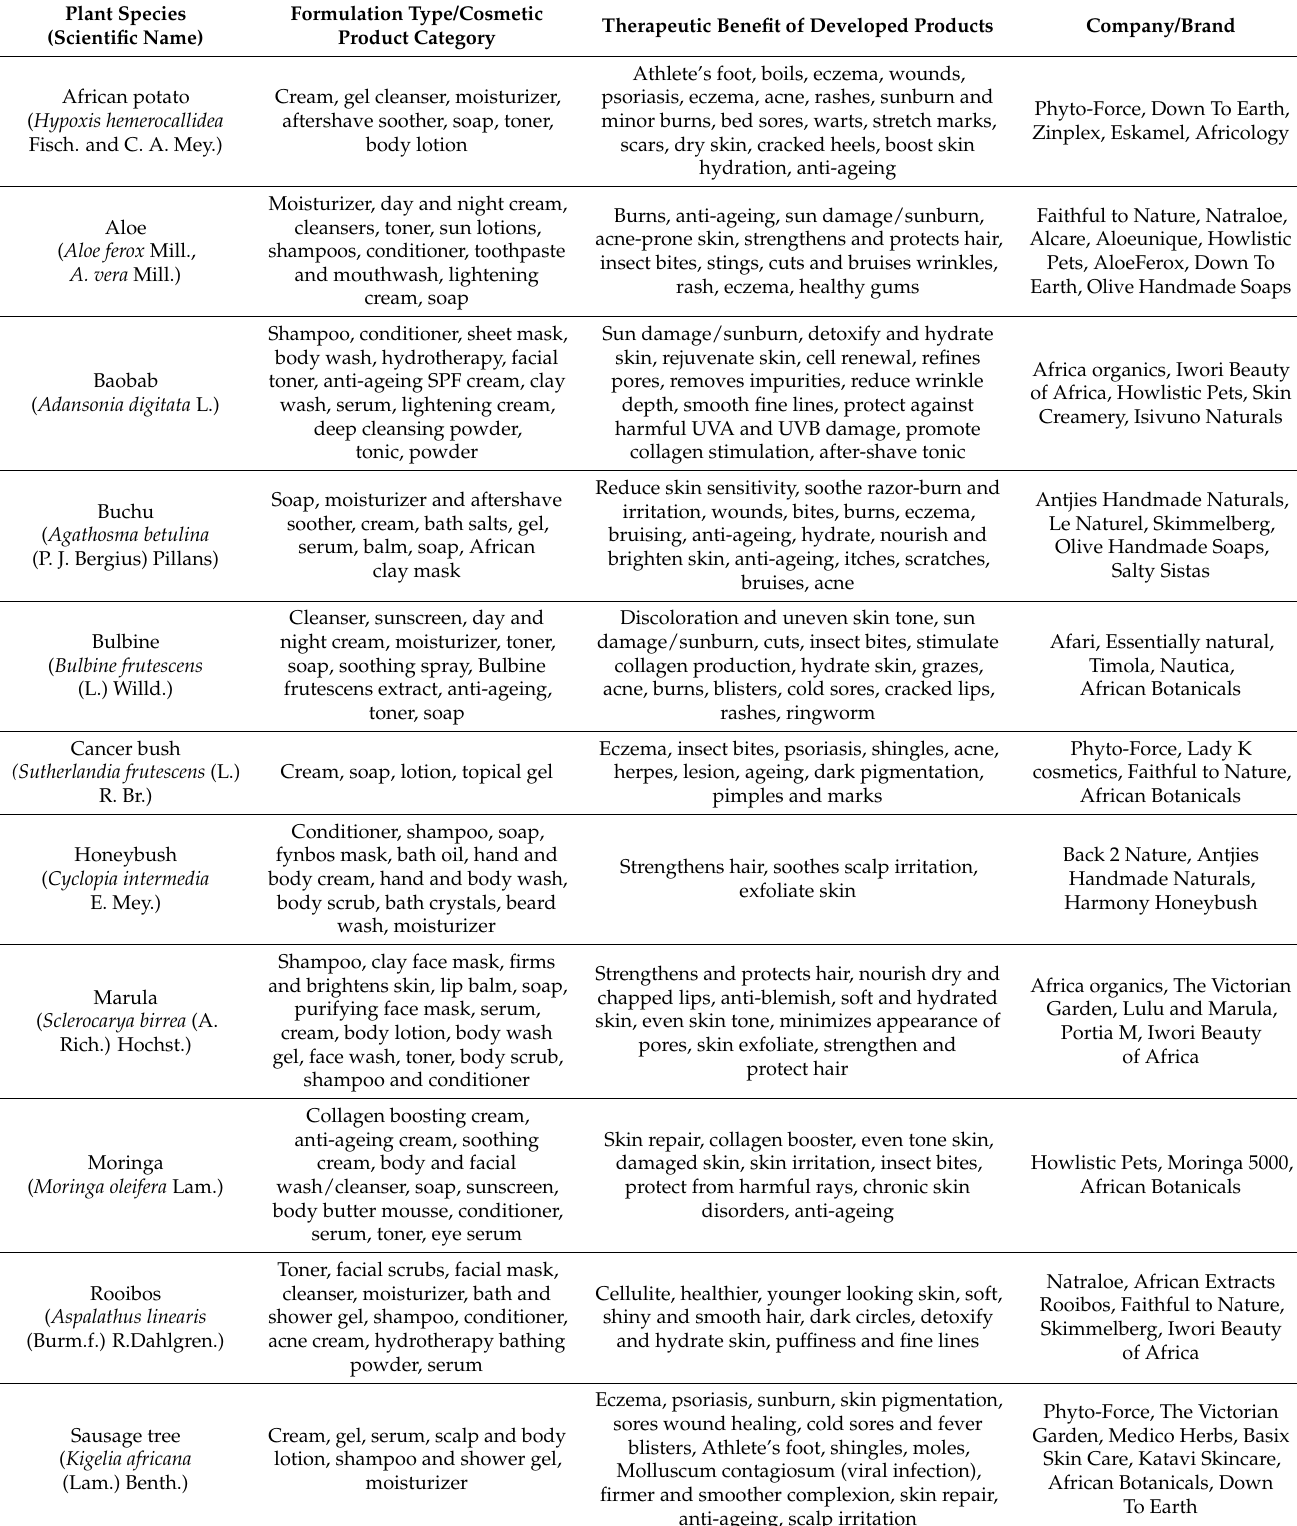
Table 1. South African cosmeceutical products developed from native/naturalized medicinal plant extracts, their therapeutic benefits, and companies/brands involved in their